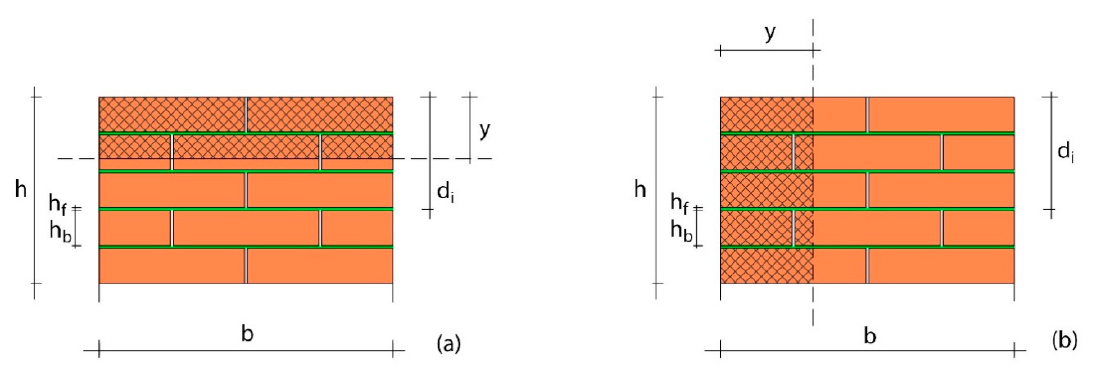
Figure 2. Cross-section of reinforced masonry ring-beam: geometric parameters. ( a ) Bending due to loads orthogonal to the bed joints; ( b ) Bending due to loads parallel to the bed joints.